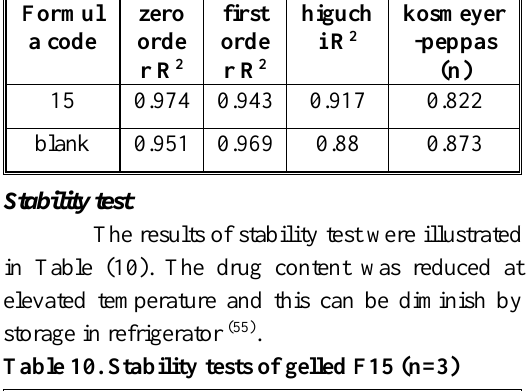
Table 10. Stability tests of gelled F15 (n=3)